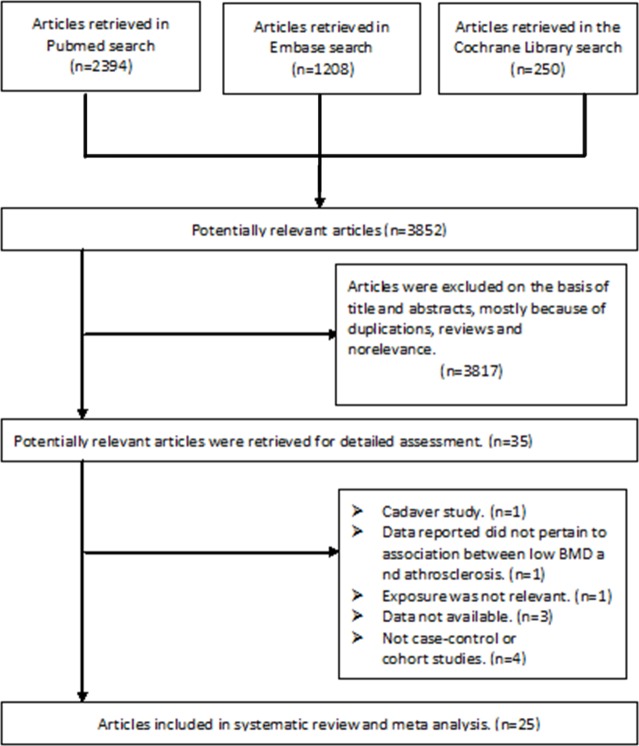
A PRISMA flowchart illustrated the selection of studies included in our systematic review.